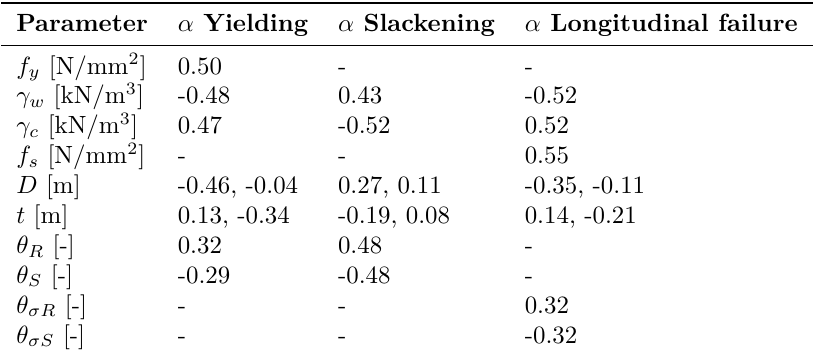
Table 3. The α -values from FORM analysis